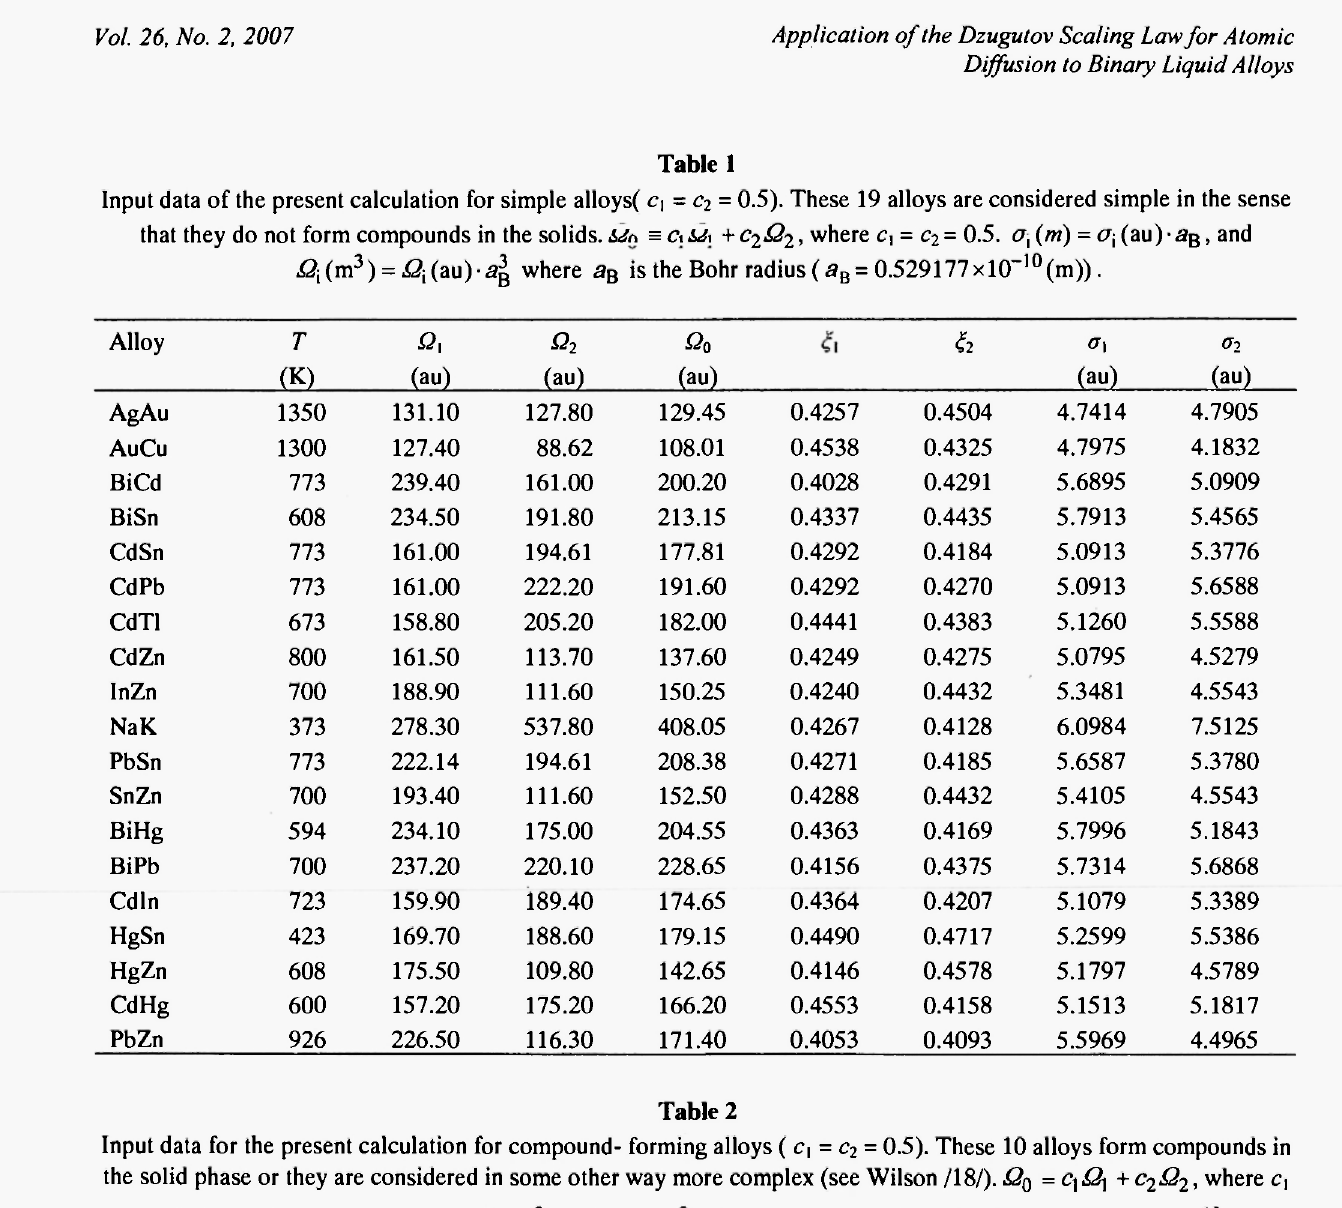
the solid phase or they are considered in some other way more complex (see Wilson /18/). Ω 0 = q ß, +c 2 i2 2 , where